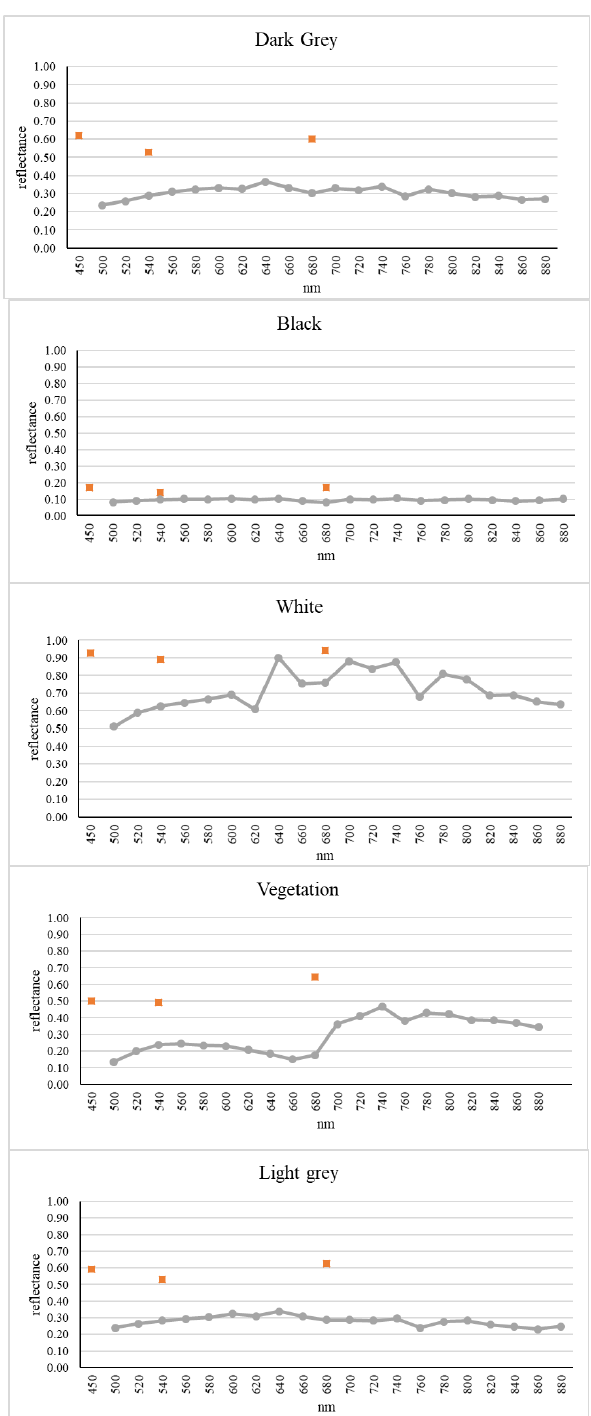
Figure 5. Plotting of spectral signatures on the SONAP (grey dots) and the Raspberry NoIR (orange squares). The wavelength is on the x-axis, while the reflectance (0-1 scale) on the